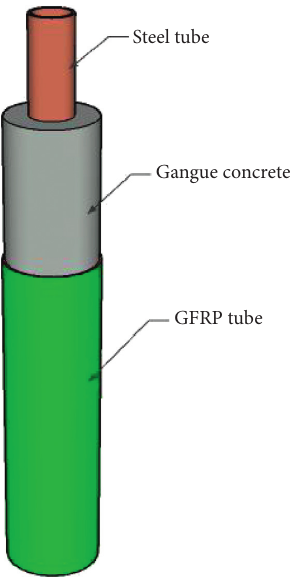
Figure 1: Glass fiber tube-gangue concrete-steel tube hollow